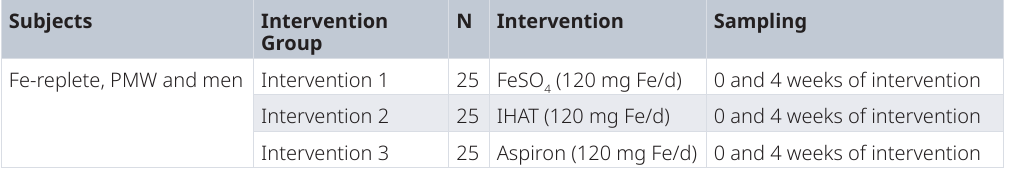
Table 2. Intervention groups for Phase II of the Safe Iron